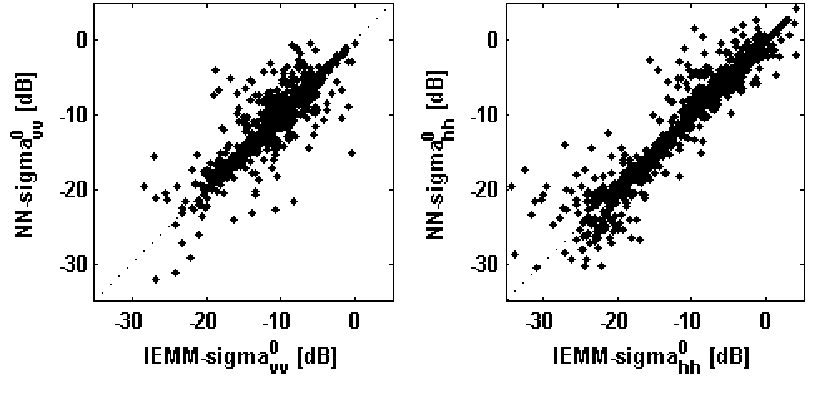
Figure 4. Same as Figure 2, but for  of 4,000